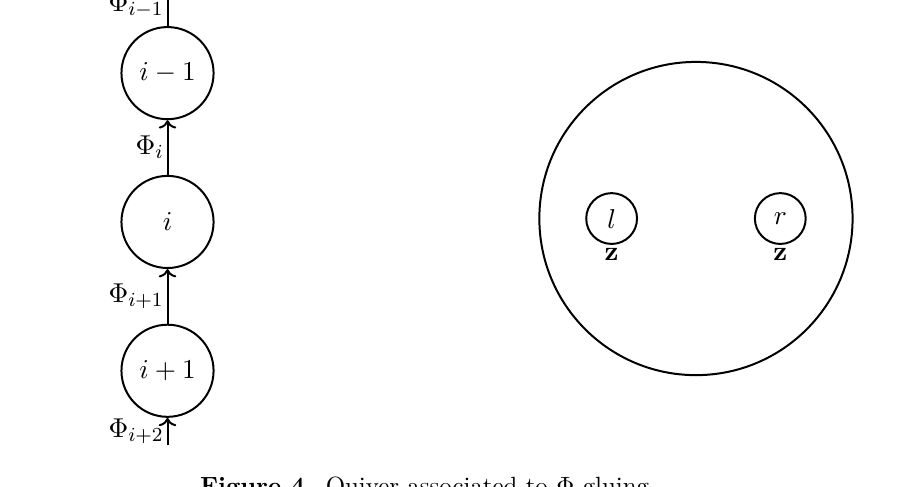
Figure 4. Quiver associated to Φ